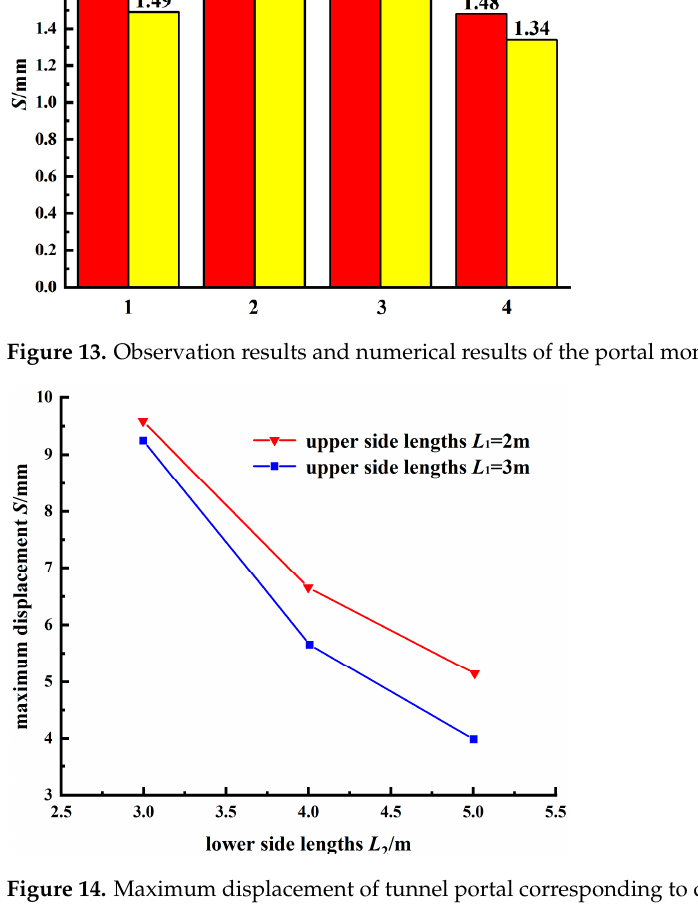
Figure 14. Maximum displacement of tunnel portal corresponding to different lower side lengths of the trapezoidal freezing soil mass.